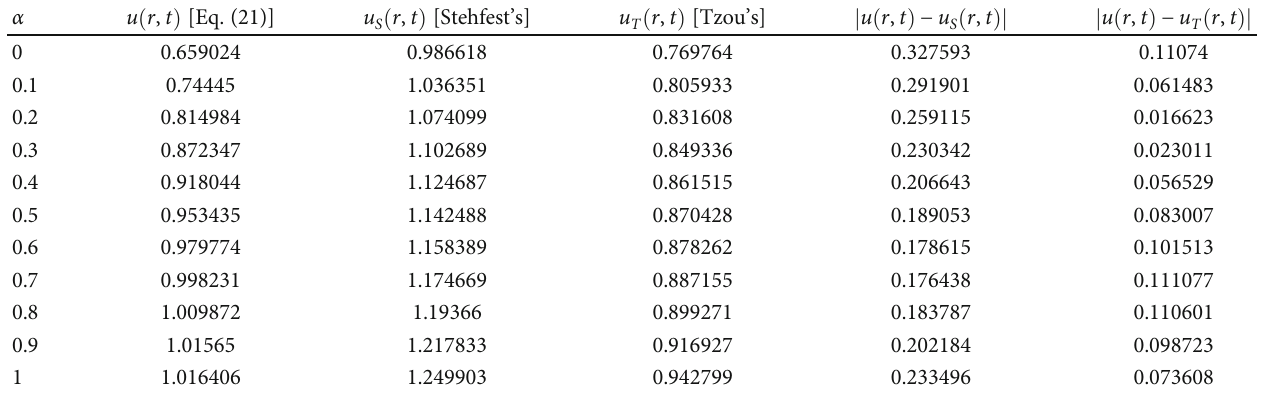
Table 2: E ff ect of noninteger order of fractional parameter on the velocity fi